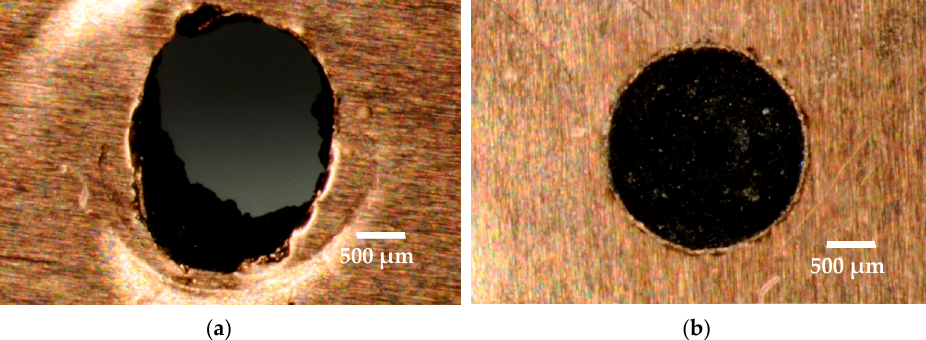
Figure 2. Images from optical microscope: ( a ) Through hole (I p =5 A, T on =100 μ s, T off =300 μ s); ( b ) Blind hole (I p =1 A, T on =200 μ s, T off =250 μ s).